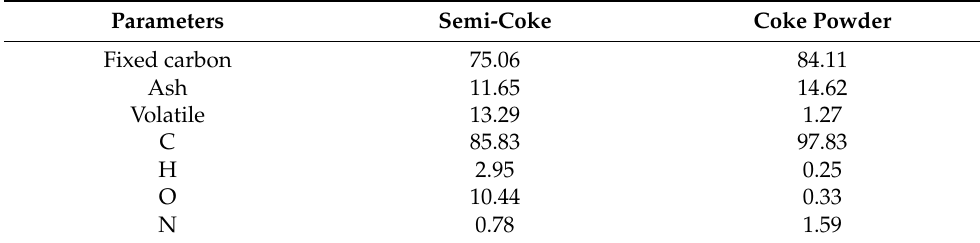
Table 4. Industrial and elemental analysis of fuels.